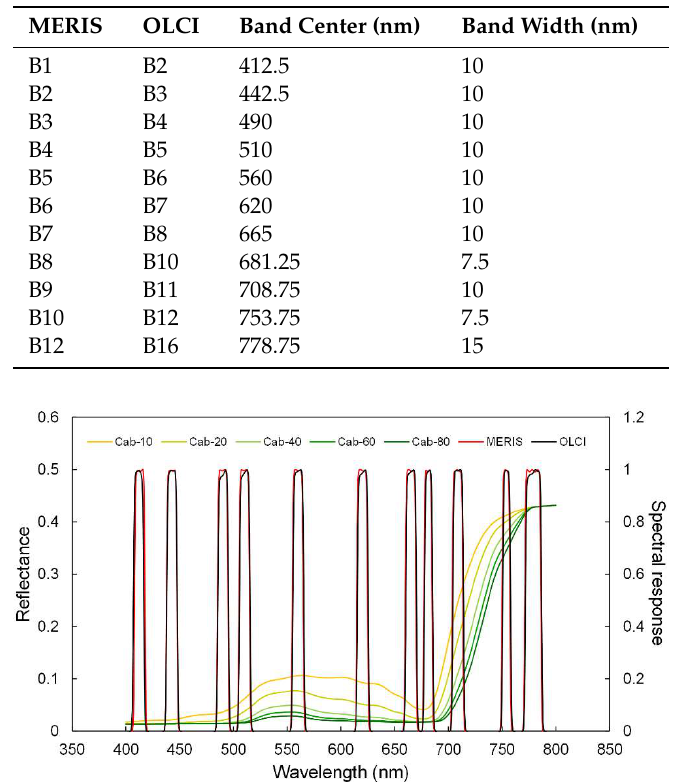
Figure 2. MERIS and OLCI images with an extent of 15 km by 15 km covering the US-Ne2 study site. The area marked with a solid white line in the center of the figure is the US-Ne2 site. Table 3. Band specifications of the MERIS and OLCI used in this study.